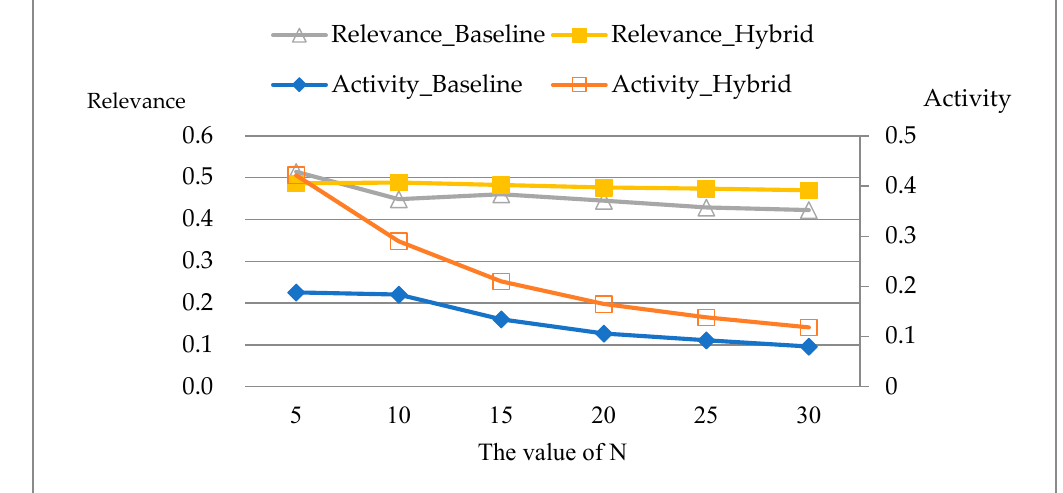
Figure 8. Comparison of Relevance and Activity.